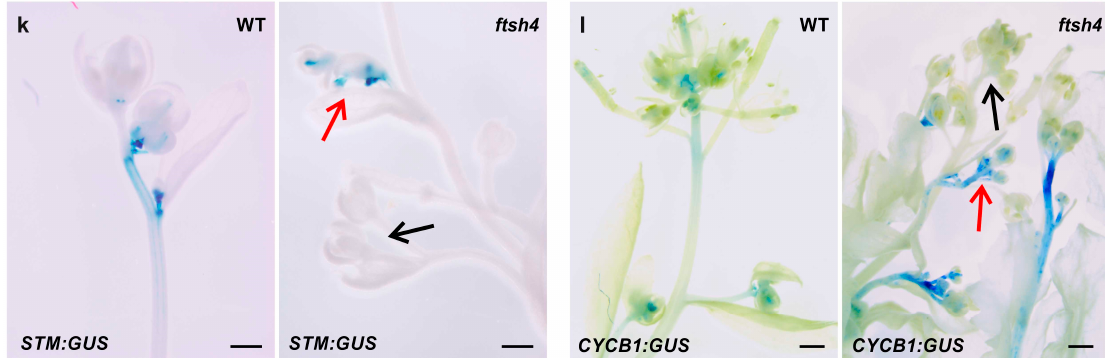
Figure 1. Impairment of proliferative activity and stem cell identity in shoots of ftsh4-1 mutants grown at 30 °C. ( a ) Phenotypes of adult wild-type (WT) and ftsh4-1 mutant plants grown under long day photoperiod (LD) conditions at 30 °C. The ftsh4-1 mutants show a different degree of shortening of the main inflorescence stem and branching prior to growth cessation (note the drying rosette leaves). Scale bar: 20 mm; ( b ) lengths of the first internode and the number and size of cells in the first internode of WT and ftsh4-1 mutant plants grown under LD conditions at 30 °C. The results are shown as relative to the WT samples (average values for WT plants are as follow: internode length 18.5 mm, cell number 54.3, elongation zone cells size 298.7 μ m). Internode length and cell number strongly decreases, while cell size is less affected in the ftsh4-1 mutants. Two biological replicates of the experiment were performed. The internode length and number of cells was measured in 10 plants of each genotype; average cell size was estimated from randomly measured 10 cells per internode. Mean values (±SE) are shown and significant differences between bars at p < 0.05 are denoted by asterisks; ( c , d ) comparison of S-phase progression (cell division) directly in the meristems of juvenile vegetative, adult vegetative and bolting wild-type and ftsh4-1 mutants grown at 30 °C. The table shows the total number of cycling cells (i.e., in S-phase) and the mitotic index (percentage of cycling cells relative to the total number of SAM cells) in juvenile vegetative, adult vegetative and bolting wild-type and ftsh4-1 mutant plants ( c ). In comparison to WT plants, a decrease in the number of S-phase cells (green signal) was detected only in adult and bolting ftsh4-1 mutant plants. Scale bars: 50 μ m ( d ); ( e ) comparison of At CDKA1 , At CYCD3;1 , At CYCB1 and At CDKB2;1 transcript levels analyzed in juvenile and adult vegetative shoot apices of WT and ftsh4-1 mutant plants grown under LD conditions at 30 °C. Abundance of transcripts in each case is expressed relative to the juvenile WT tissue samples. Results from three experiments are shown; ( f ) the comparison of At STM transcript level analyzed in juvenile and adult vegetative shoot apices of WT and ftsh4-1 mutant plants grown under LD conditions at 30 °C. Abundance of transcripts is expressed relative to the juvenile WT tissue samples. Results from three experiments are shown; ( g , h ) activity of the At CYCD3;1 and At CYCB1 ( g ) as well as At STM ( h ) promoters visualized by the activity of the GUS reporter protein ( blue ). Transgenic plants were grown under LD conditions at 30 °C and expression levels were analyzed during the juvenile vegetative stage of development of the WT ( upper panels ) and ftsh4-1 mutants ( lower panels ). In each case, ftsh4-1 mutants were characterized by weaker GUS activity. Scale bars: 3 mm; ( i , j ) activity of the At CLV3 promoter visualized by the activity of the GUS reporter protein ( blue ). At 30 °C, in the juvenile SAM, GUS activity accumulates similarly in both genotypes ( i ), but in adult vegetative SAM (prepared with vibratome sections), ftsh4-1 mutants are characterized by weaker and more diffusible GUS activity in comparison to the WT ( j ). Scale bars: 3 mm ( i ) and 20 μ m ( j ); ( k , l ) activity of the At STM ( k ) and At CYCB1 ( l ) promoters visualized by the activity of the GUS reporter protein ( blue ). Plants were grown under LD conditions at 30 °C and expression levels were analyzed during the generative stage of development. After transition to flowering, GUS activity in adult ftsh4-1 mutant plants grown is variable (in terms of the strength of the signal) in the inflorescence apices (black arrows point exemplary shoot apices without GUS signal, red arrows—exemplary shoot apices with GUS signal). Scale bar: 15 mm.